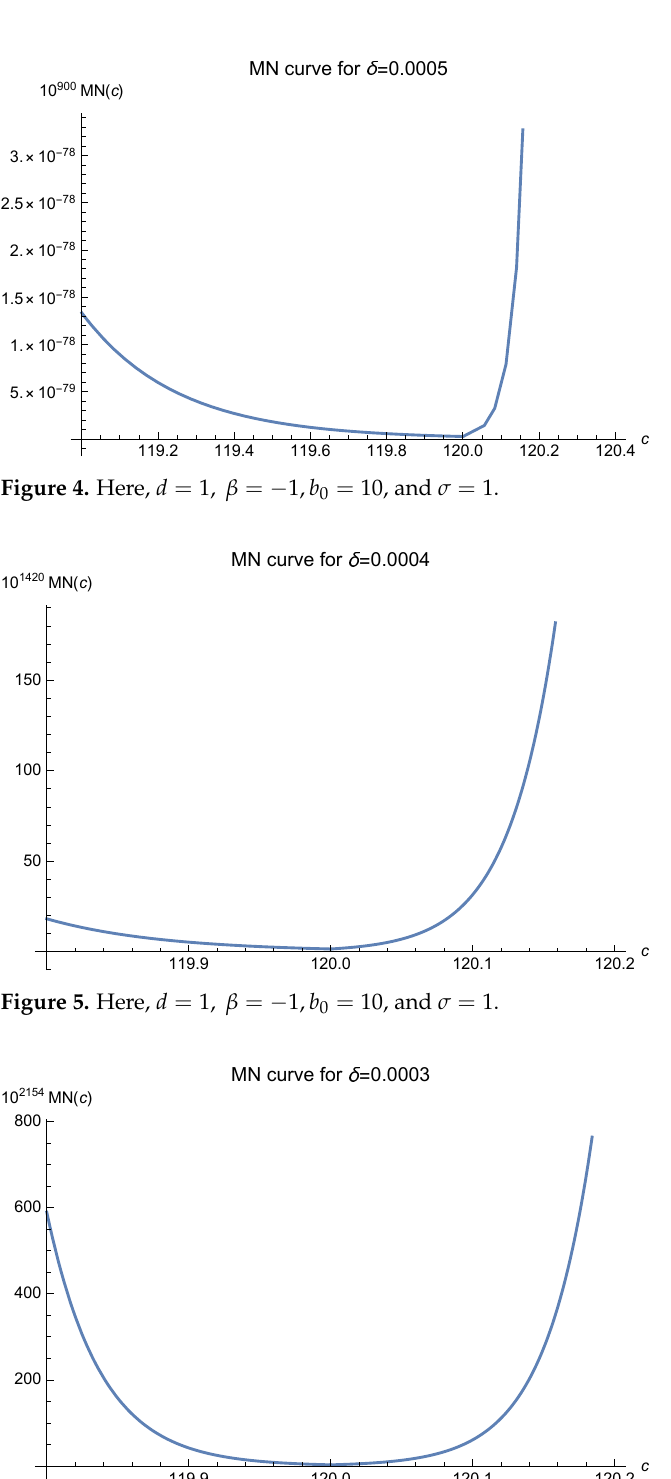
Figure 6. Here, d = 1, β = − 1, b 0 = 10, and σ =